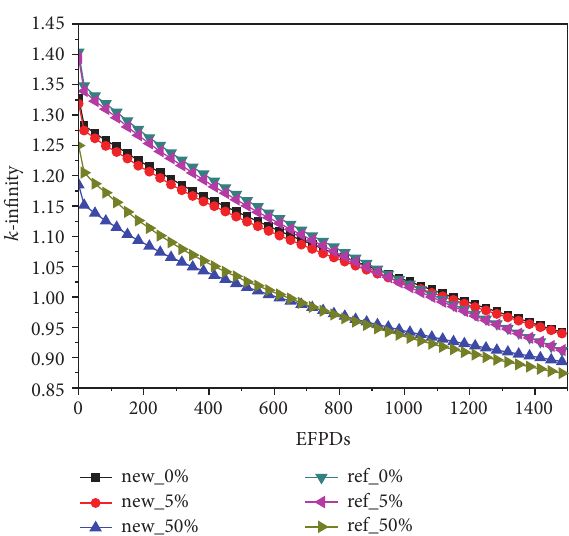
Figure 19: Concentration of 239 Pu with different percentage of void of moderator.